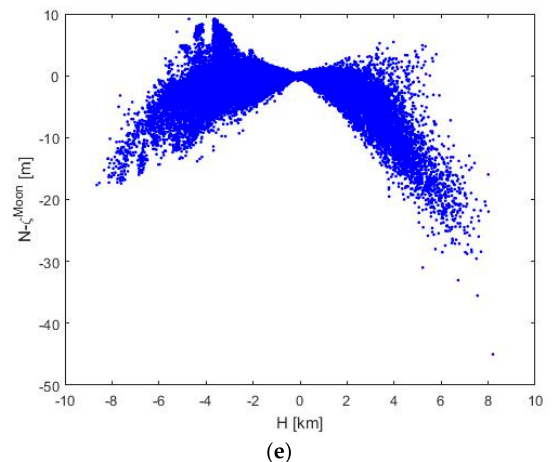
Figure 4. Spatial correlation between the geoid-to-quasigeoid separation and the topography on ( a ) Mercury, ( b ) Venus, ( c ) Earth, ( d ) Mars and ( e ) the Moon.